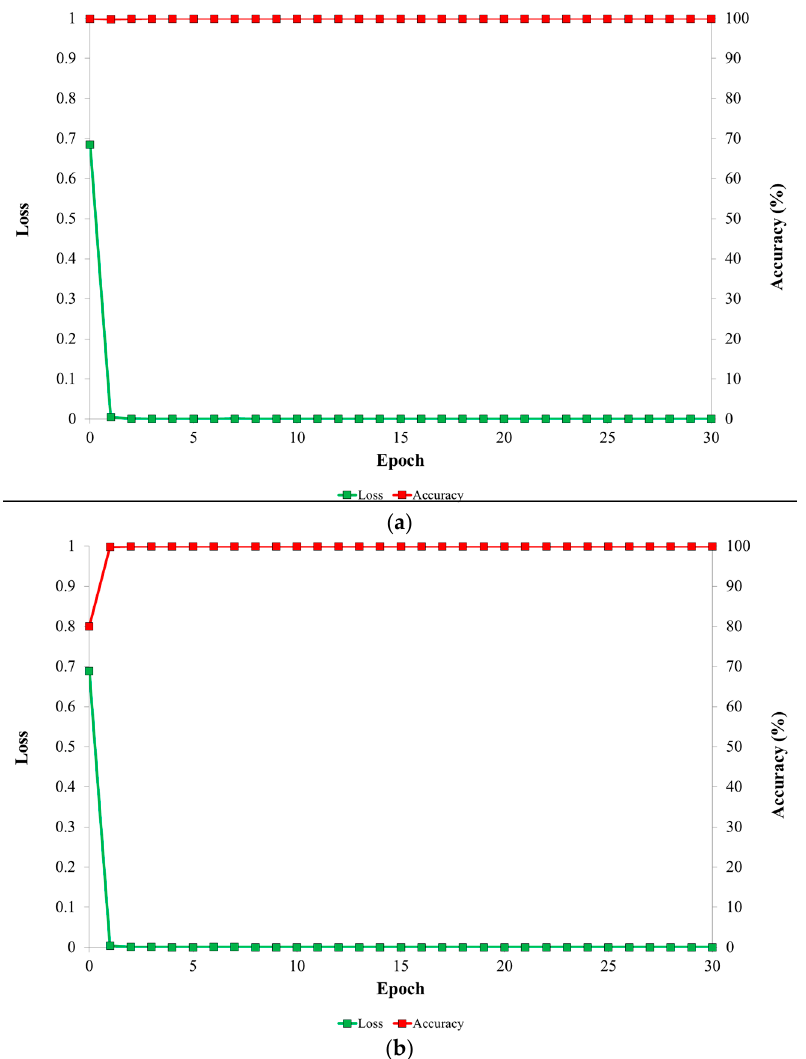
Figure 6. Graphs of loss and accuracy for each epoch during the training procedure. ( a ) The 1st fold of cross validation; ( b ) The 2nd fold of cross validation.